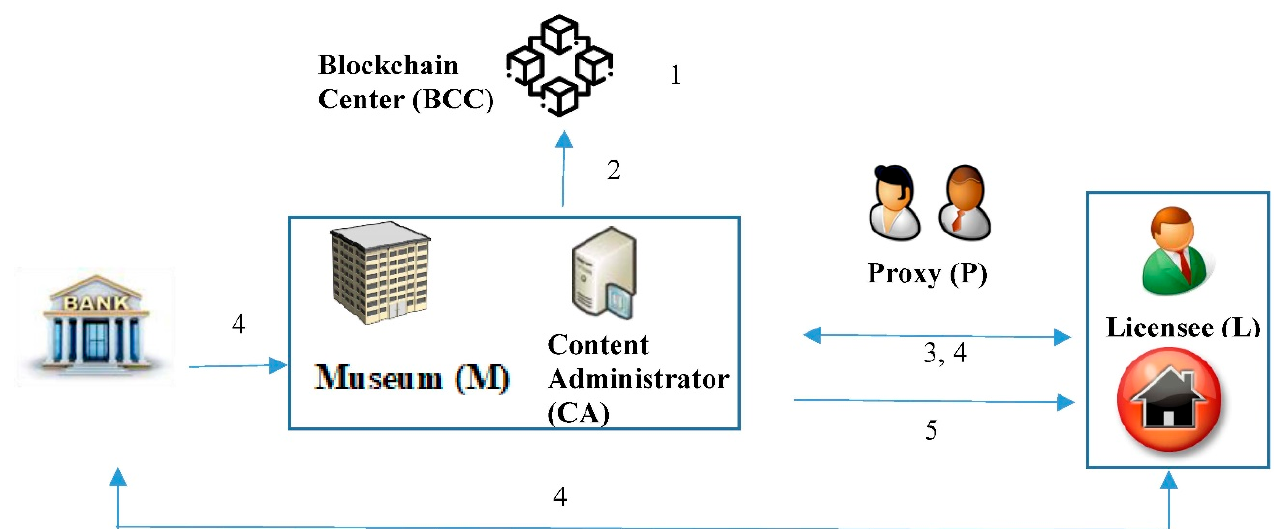
Figure 3. The system architecture.